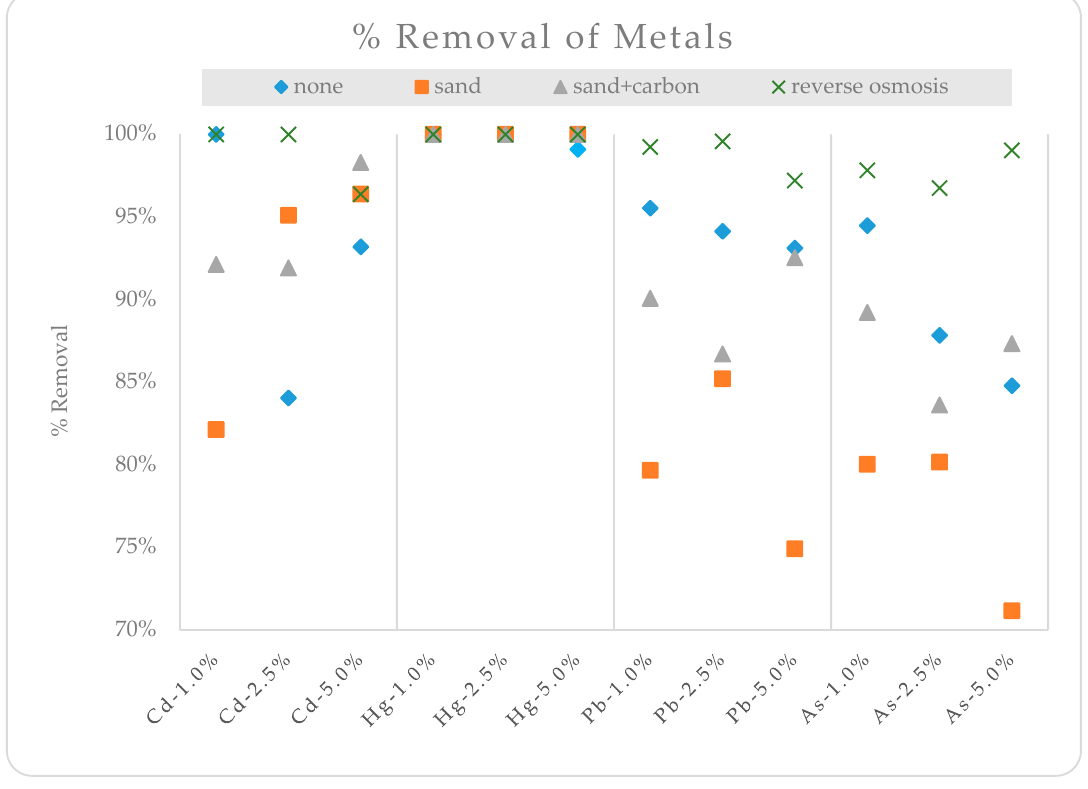
Figure 4. The percent removal of each metal from the four treatments and three mixtures.